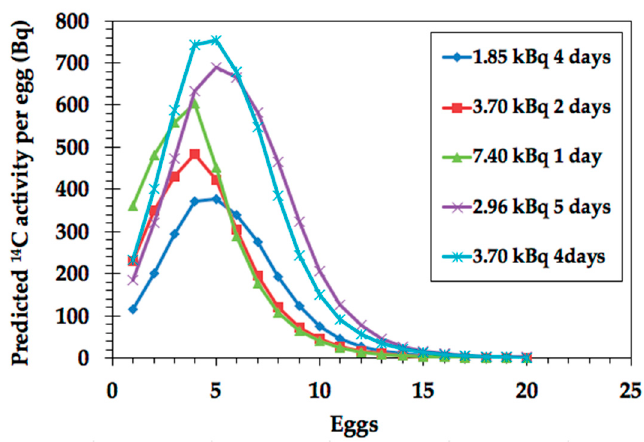
Nutrients 2019 , 10 , x FOR PEER REVIEW